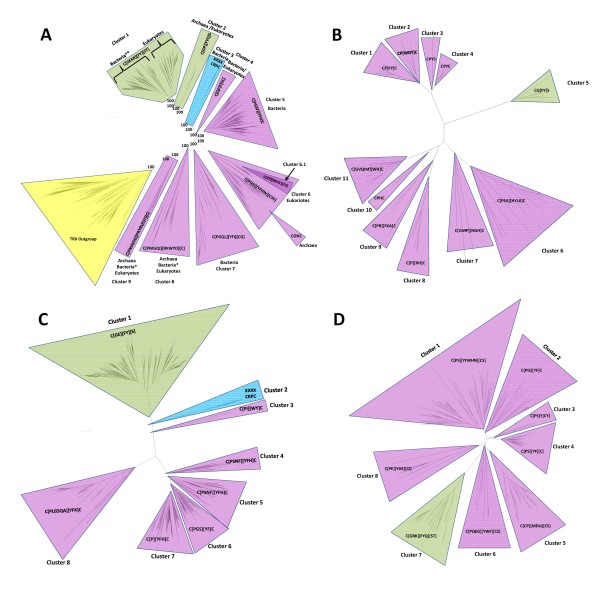
Condensed phylogenetic tree for single domain GRXs from UNIPROT database. Panel A: Global tree. The outgroup on the lower left of the tree is composed of TRX single domain proteins (in yellow). All major divisions between clusters have bootstrap values of 100%, indicated by the "100" label. The CGFS class of GRXs is depicted on the upper branchs [in green]. Sequences are more homogeneous on this class. The mid-lower branches depict CPYC class GRXs [in mauve]. There is a wider variability in the sequences of this class. The clusters identified with the tag "Bacteria*" include almost all non-proteobacteria GRX domains. These include domains from Actinobacteria, Deinnococcus, Planktomycetes, Green sulfur bacteria, Green non sulfur bacteria, Thermotoga, Aquifaceae, and Flavobacteria. The cluster identified with the tag "Bacteria**" include mostly proteobacteria GRX domains. GRX domains from Cyanobacteria and Spirochaetes are also present in this cluster. Panel B: Condensed phylogenetic tree of single domain GRXs in archaea. Panel C: Phylogenetic tree of GRX proteins for bacteria. CGFS class GRXs [Cluster 1] have less variability in their sequence than CPYC class GRXs [other clusters]. Some GRX-like proteins have lost their active site [XXXX in Cluster 2]. Panel D: Phylogenetic tree of GRX proteins for eukaryotes. CGFS GRXs [in green] have less variability in their sequence than CPYC GRXS [in mauve]. Nevertheless, the variability in the sequence of the active site for CGFS GRXs is far greater than that found in bacteria [compare to panel C].